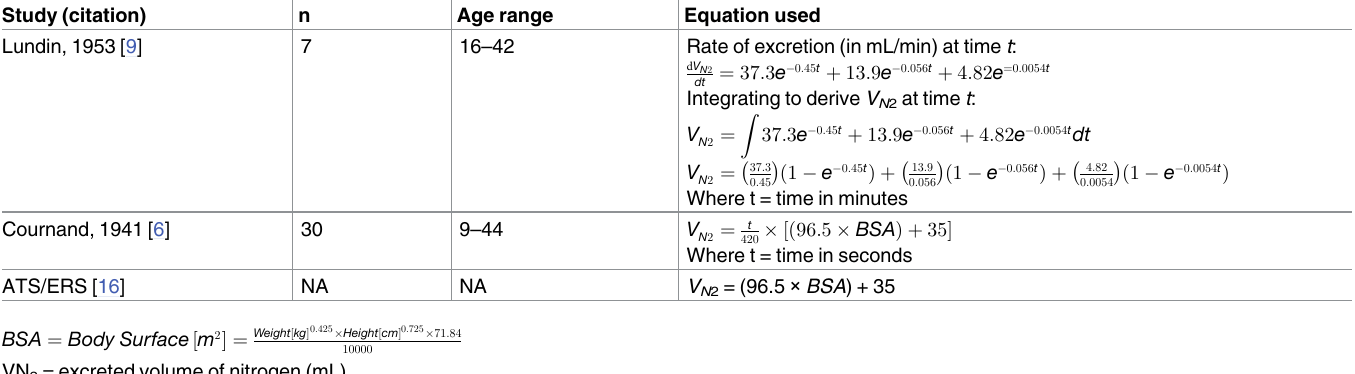
Table 1. Summaryof tissue nitrogen correction